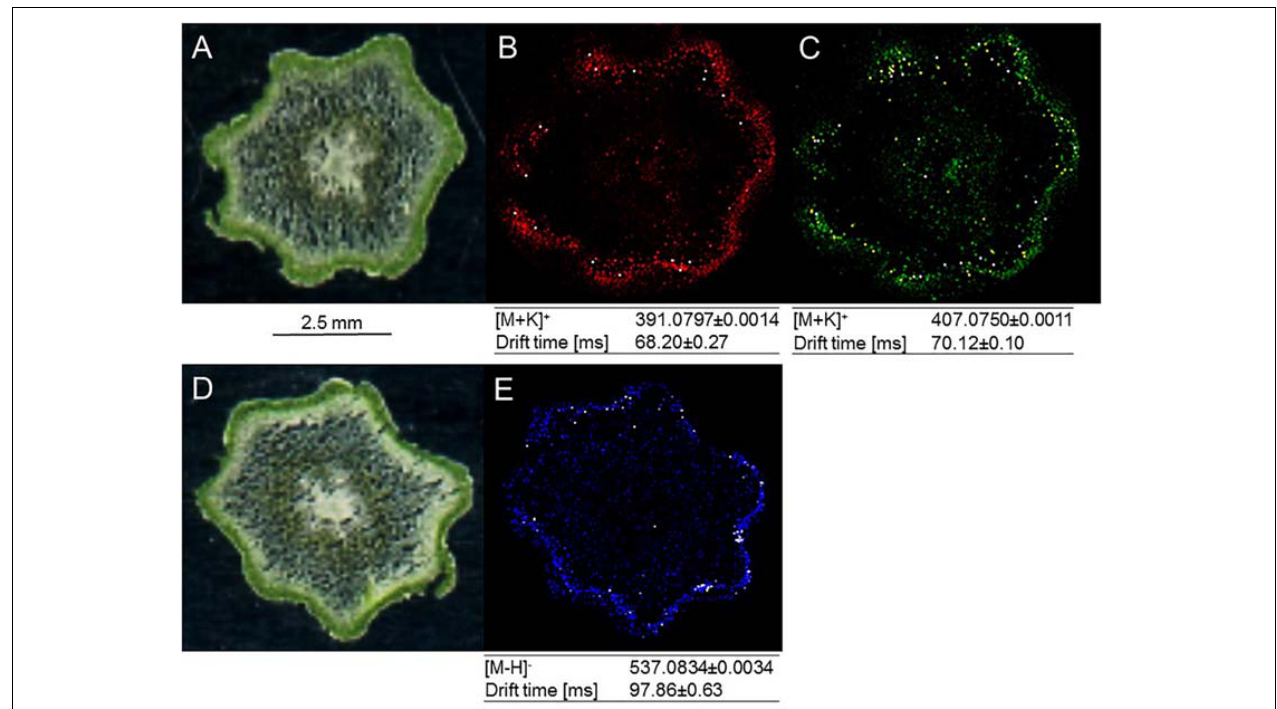
FIGURE 5 | MALDI-MS imaging of specialized metabolites in cross sections of P. nudum above-ground rhizomes (stems). (A) Image of specimen for arylpyrone glycoside analysis; (B) [M+K] + signal for psilotin (colored in red); (C) [M+K] + signal for 3 (cid:48) -hydroxypsilotin (colored in green); (D) image of specimen for biflavonoid analysis; (E) [M–H] − signal for amentoflavone (colored in blue). Note the accumulation of metabolites of interest in the chlorenchyma (dark green tissue in specimen